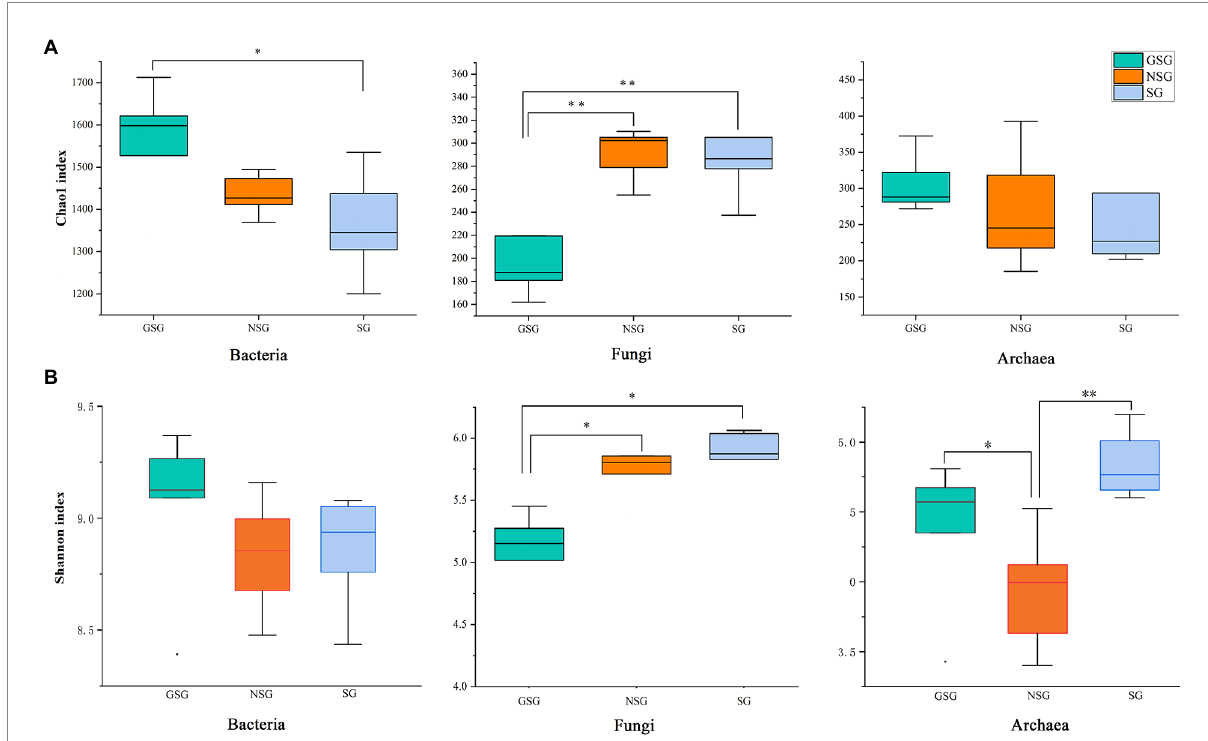
FIGURE 1 Differences in Yak rumen microbial diversity and richness between the GSG, NSG, and SG. Diversity was estimated by Shannon index. Richness estimated by the Chao1 value. (A) Chao 1 index. (B) Shannon index. Asterisks indicate significant difference between the Concentrate Group and the Forage Group ( * p ≤ 0.05; ** p ≤ 0.01).